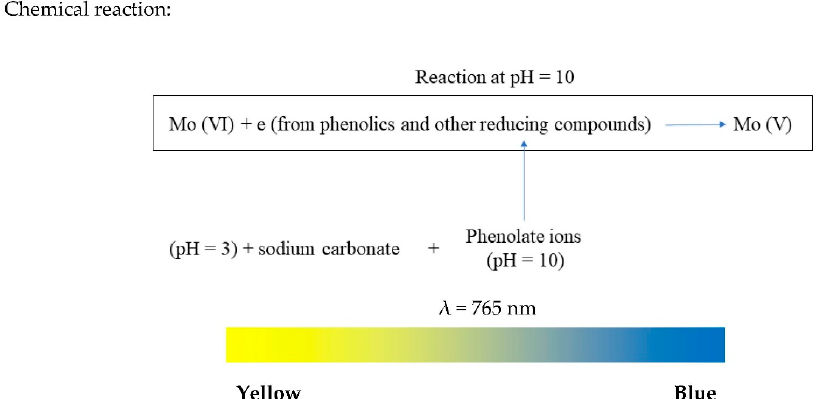
Figure 2. Folin–Ciocalteu (F–C) assay.